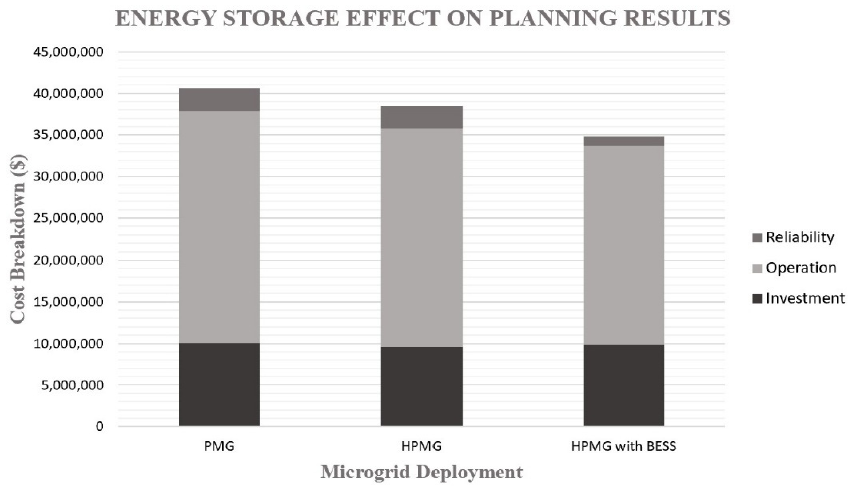
Figure 6. Energy storage effect on planning results.